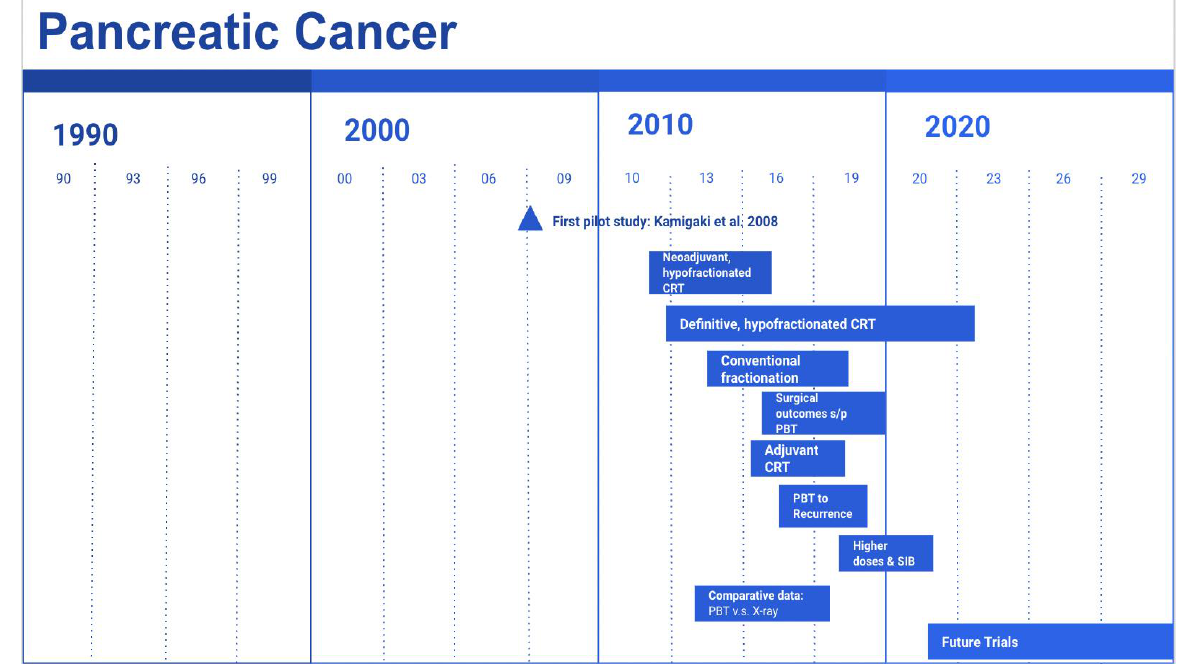
Figure 1. Timeline of clinical studies on the use of proton therapy in the management of pancreatic cancer.